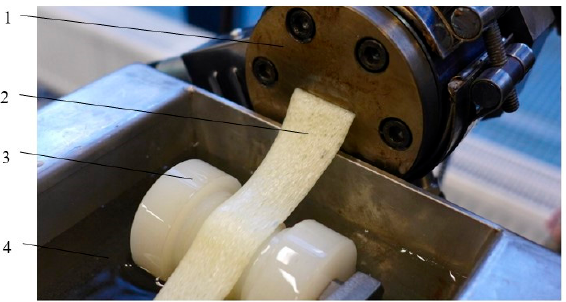
Figure 2. View of the extrusion head with the extruded tape with microporous PLA: 1—extruder head, 2—extrudate, 3—guide rollers, 4—cooling factor (water).